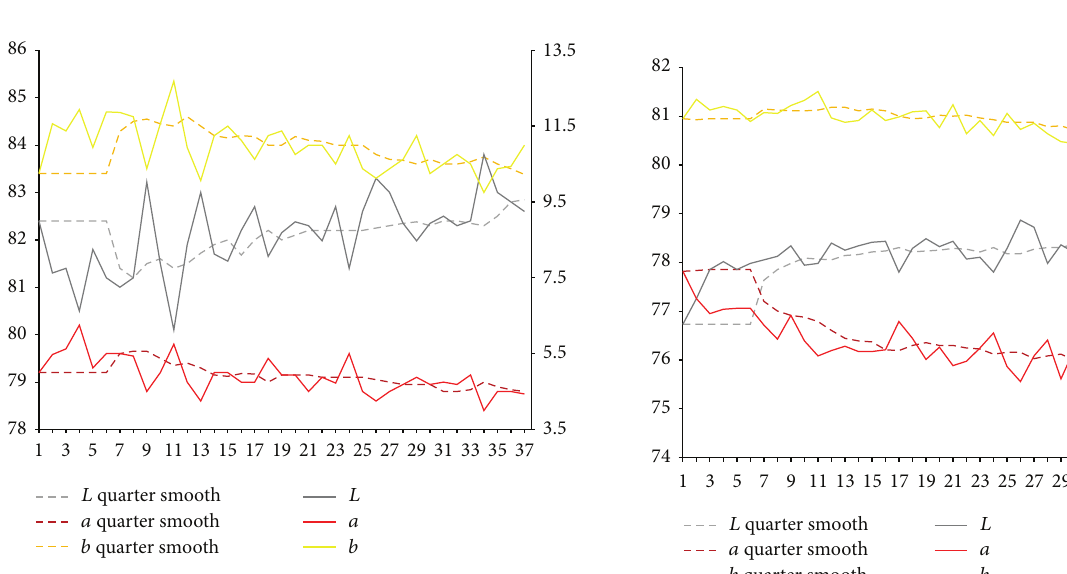
cardiac systolic function and the appearance of peripheral resistance. On the characterization, mainly, color and pulse condition are not significantly affected. Red color is the reaction of tongue body and the thin white coating is the reaction of the coating on the